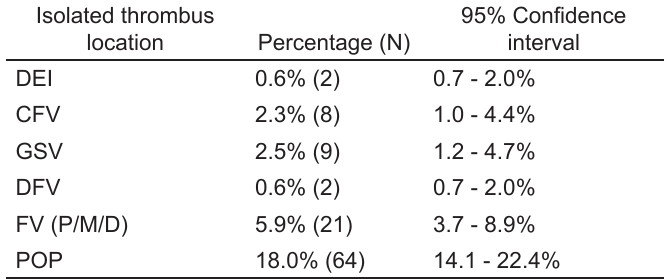
Table 3. Number and rate of isolated lower extremity thrombi.